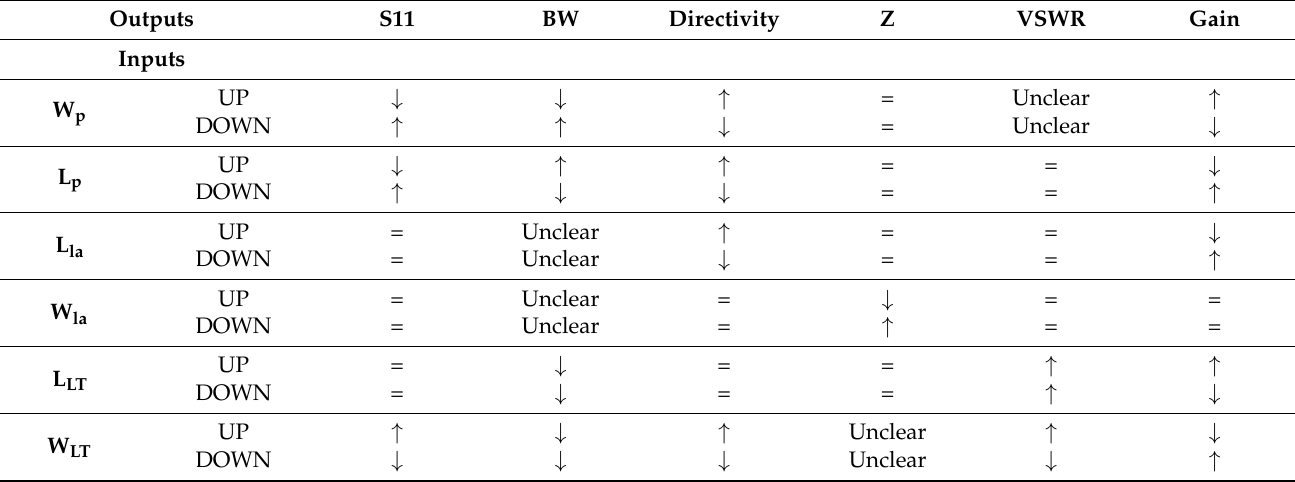
Table 6. Result of the study of simulating the λ /4 antenna with different input